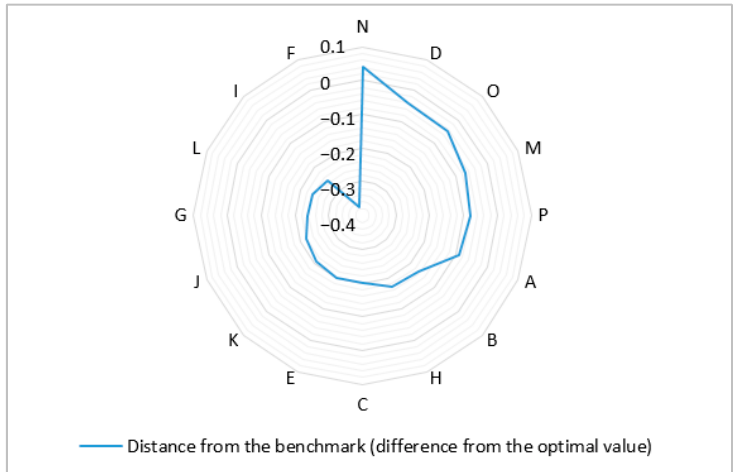
Figure 4. Determining the distance from the reference standard on the integrated indicator of fi- nancial support for the textile enterprises development (Source: author’s own